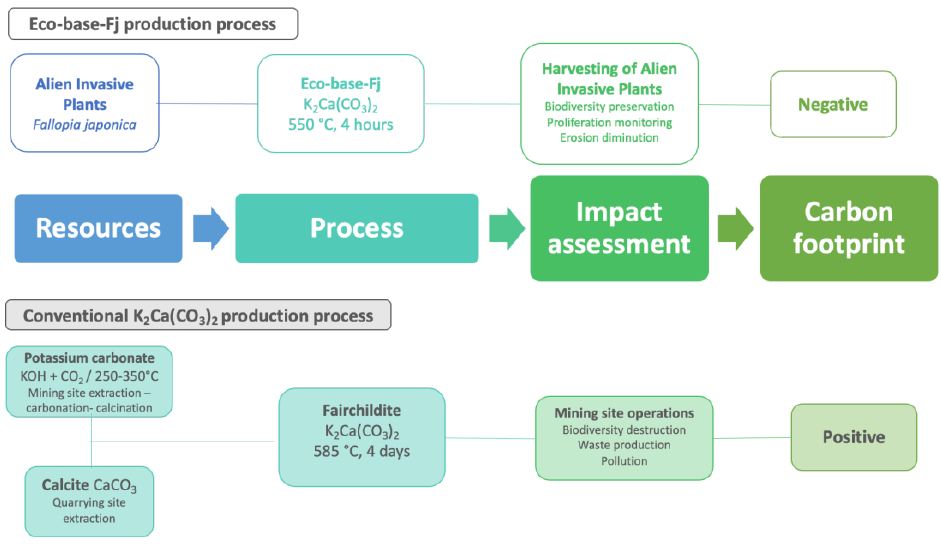
Figure 4. Global process of Eco-base-Fj production.